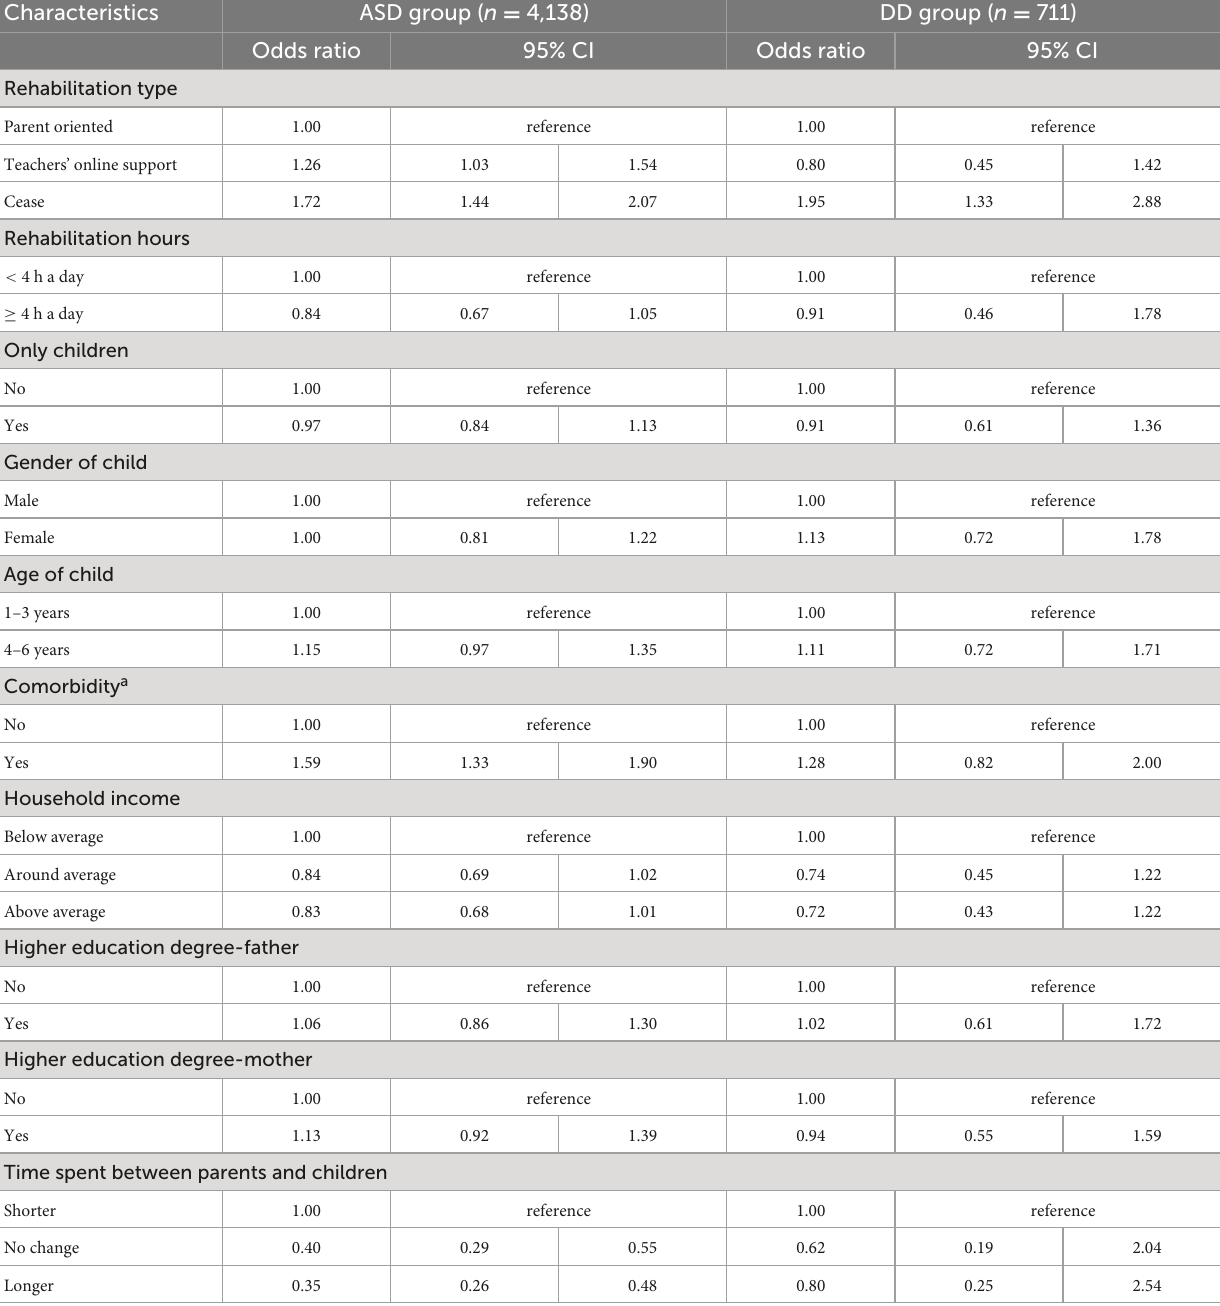
TABLE 4 Logistic regression analysis for variables predicting the negative emotional and behavioral change* of children in two groups.